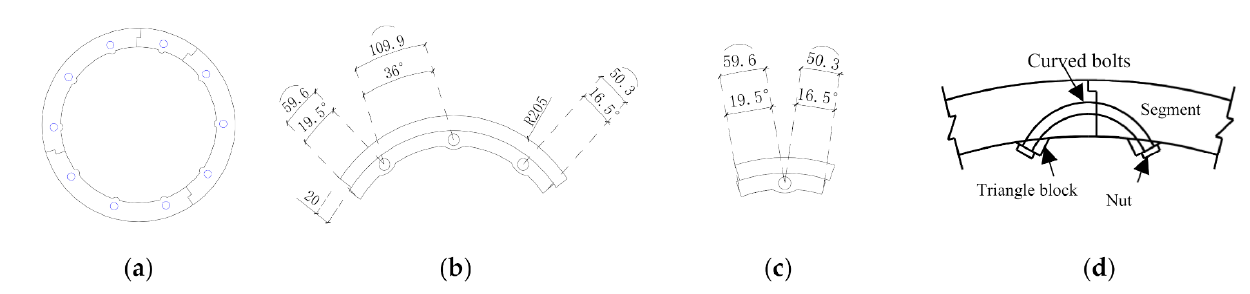
Figure 1. StructureandconnectionoftheLCSS.( a )Segmentring; ( b )Standardblock; ( c )Adjustingblock; ( d )Circumferentialconnection.